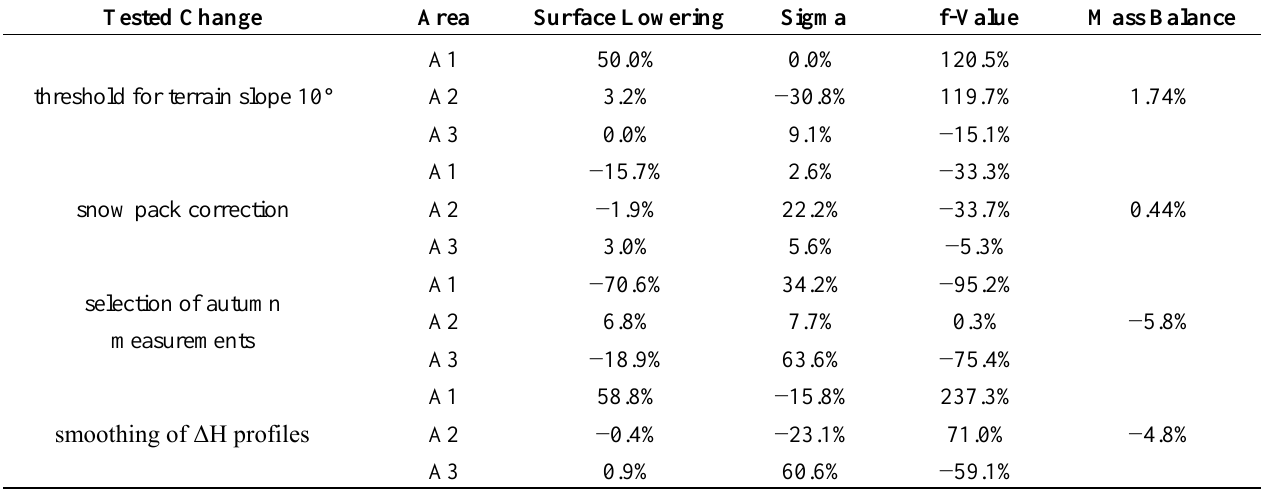
Table 3. The effect of various approaches in the processing of ICESat data on the trend in ΔH, the error range, the statistical significance and the resulting mass balance are expressed in percentages. The calculation is based on the Airphoto DEM for